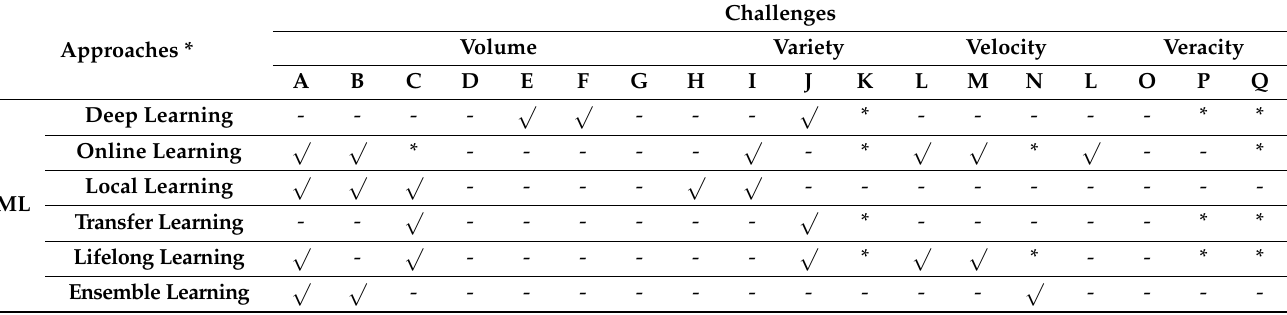
Table 4. Comparison of adaptations made in ML to be used in Big Data